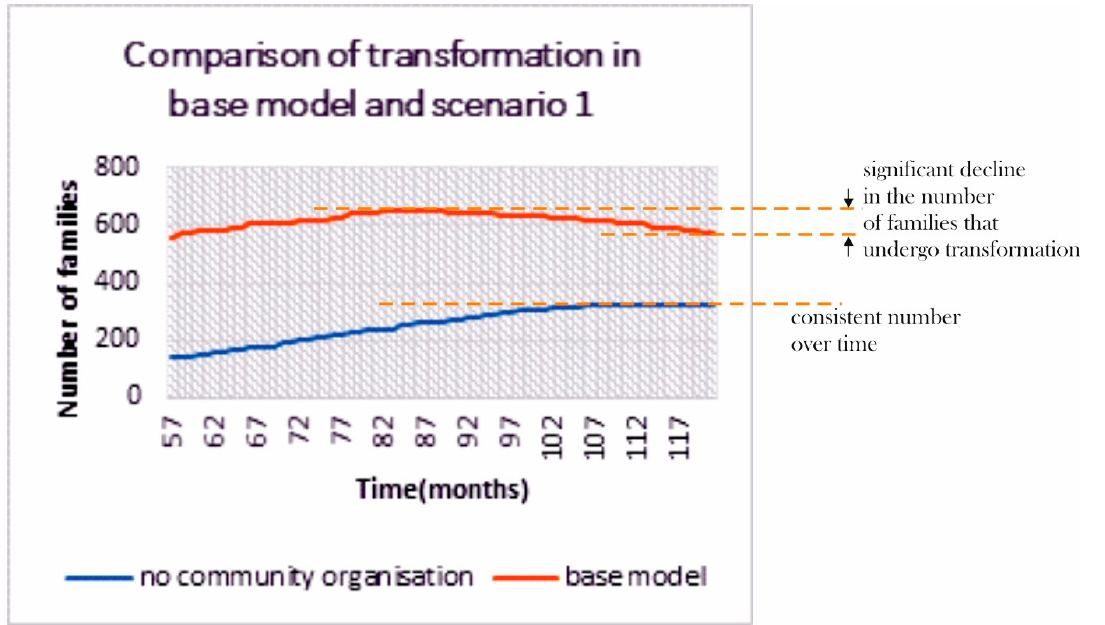
Figure 5. The decline in the number of families that undergo transformation in the base model when compared to the results of the scenario